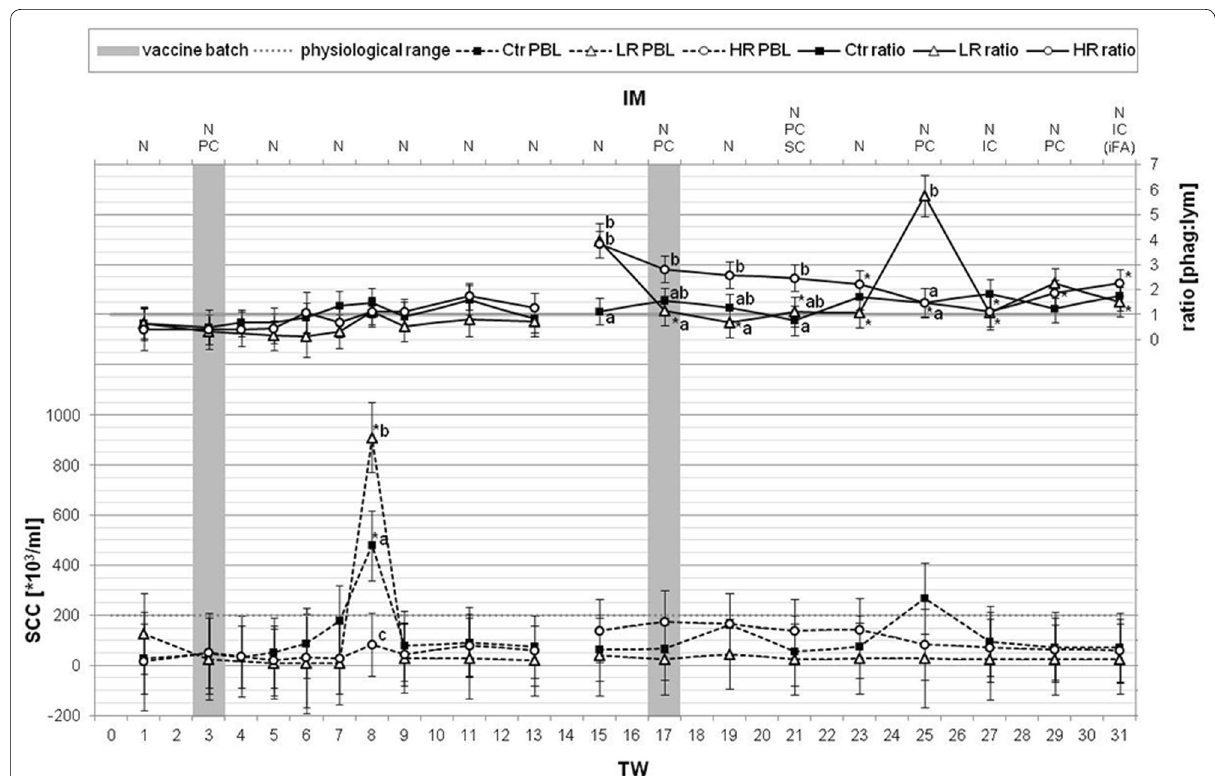
Fig. 5 Total SCC in milk and the associated ratio of phagocytes to lymphocytes. Within 31 treatment weeks (TW), the recorded total SCC in milk are shown in groups [“Ctr” control animals (n 5), “LR” treated, low responder animals (n 4), “HR” treated, high responder animals (n 5)] as LSM SD = = = ± on the lower vertical axis. The gray dotted line at 200 thousand cells per milliliter marks the commonly used cut-off value for normal SCC. The upper line chart depicts the ratio of phagocytes to lymphocytes in milk. The routes of vaccination [nasal (N), percutaneous (PC), subcutaneous (SC) and intracutaneous (IC), incomplete Freund’s adjuvant (iFA)] are presented on the upper abscissa on the immunization (IM) dates. Two gray bars represent the IM times using the MucoCD - I vaccine batches A or B. The asterisks ( p < 0.05) indicate the inner-group deviations in relation to the dates before the initial uses of both MucoCD - I vaccine batches. The significant differences ( p < 0.05) between groups on the same dates are marked by lower case letters (a, b,